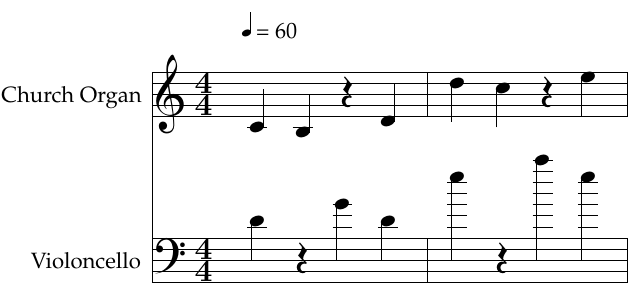
Figure 4. Resulting score from Iteration 3 (see Audio S4).